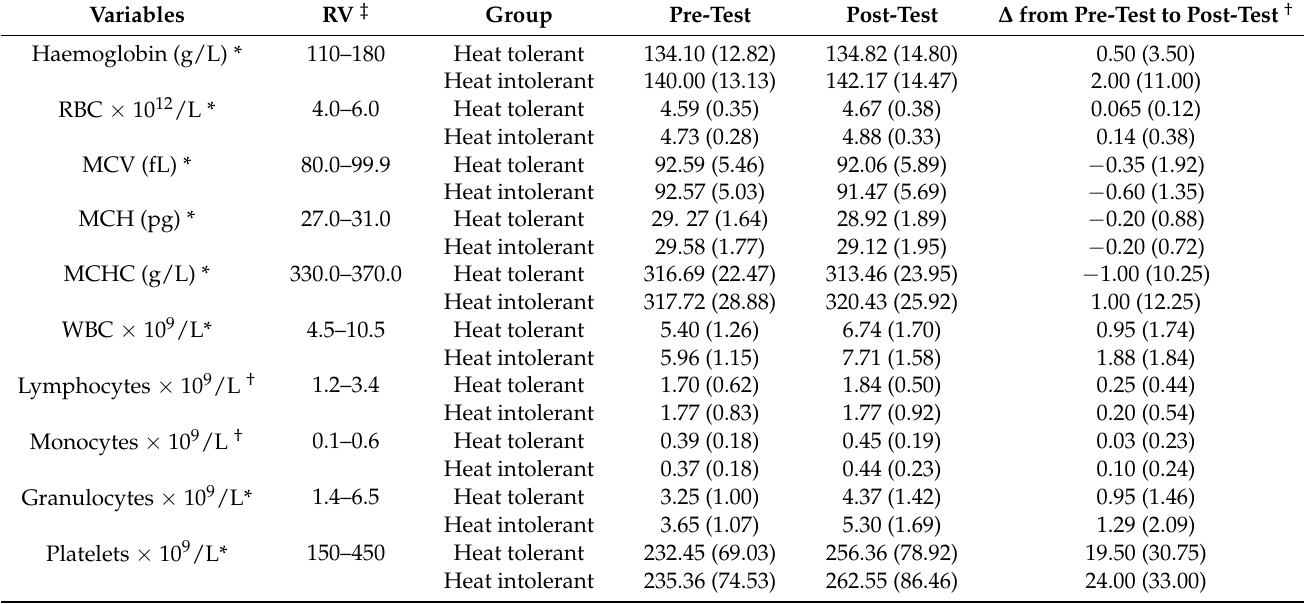
Table 1. Differences in haematological measures between heat-tolerant and intolerant